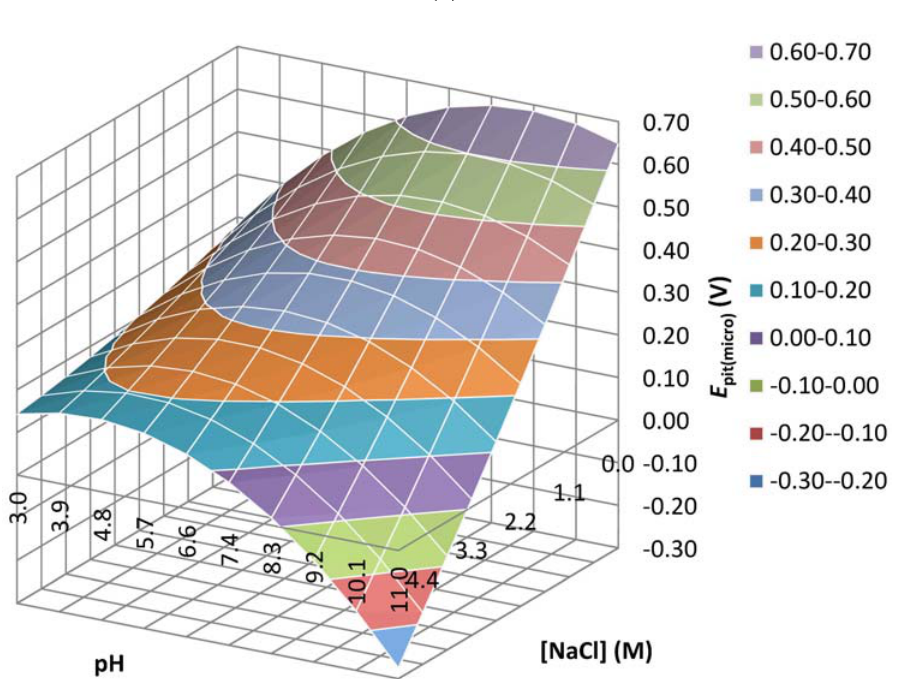
Figure 4. Response surface plots obtained from the central composite design by